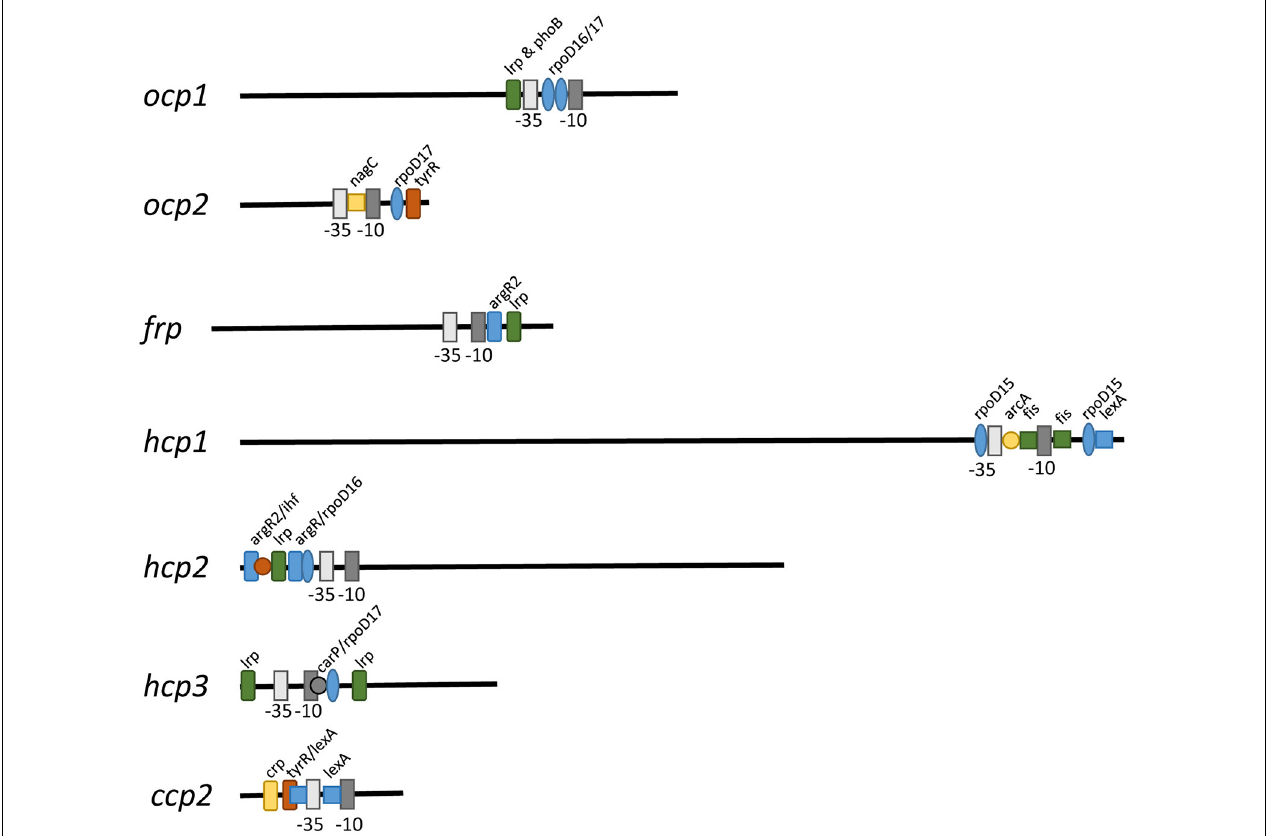
FIGURE 7 | Promoter elements found in ocp homologs. The intergenic region upstream of each ocp homolog was analyzed using BPROM (Solovyev and Salamov, 2011) to predict transcription start positions (–10 and –35 sites) and transcription factor binding sites for each predicted promoter. Distinct binding sites are denoted with identical shapes and colors across distinct